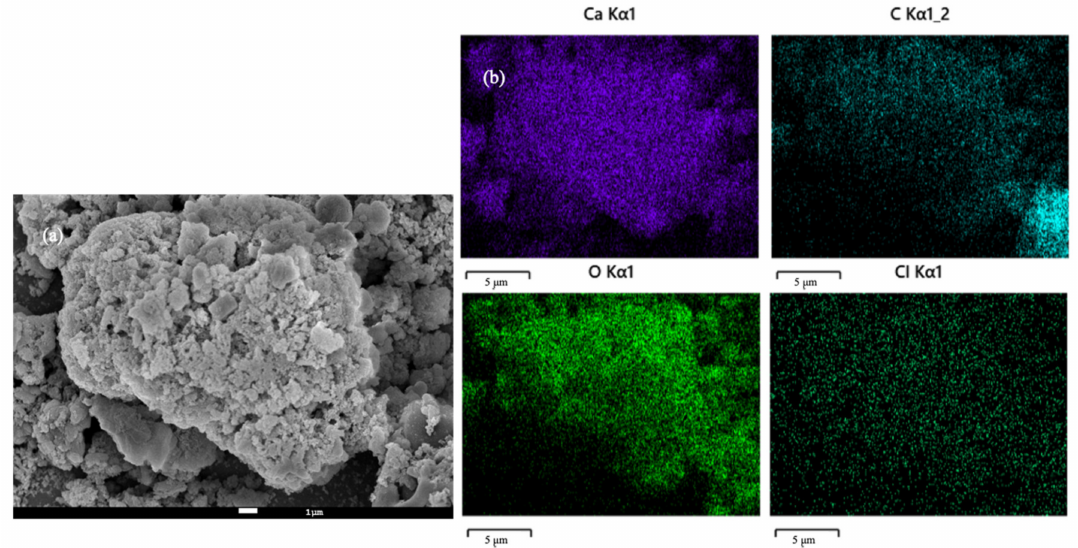
Figure 9. SEM image ( a ) and SEM/EDS ( b ) of UAW treated fly ash using EDTA-Na 2 at 20